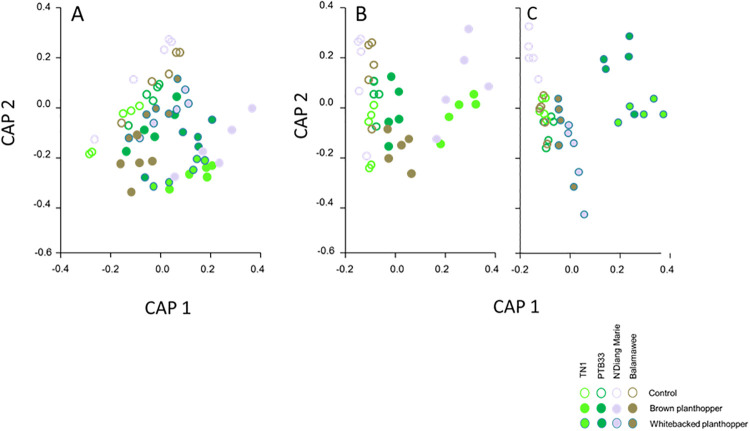
Bi-plots after Canonical Analysis of Principal coordinates (CAP) indicating clustering of four varieties and treatments with analysis (A) combined for both planthopper species, or with (B) brown planthopper alone and (C) whitebacked planthopper alone.Note that controls and ‘resistant’ varieties have values of CAP1 < 0.1 and CAP2 > -0.3 on each graph.